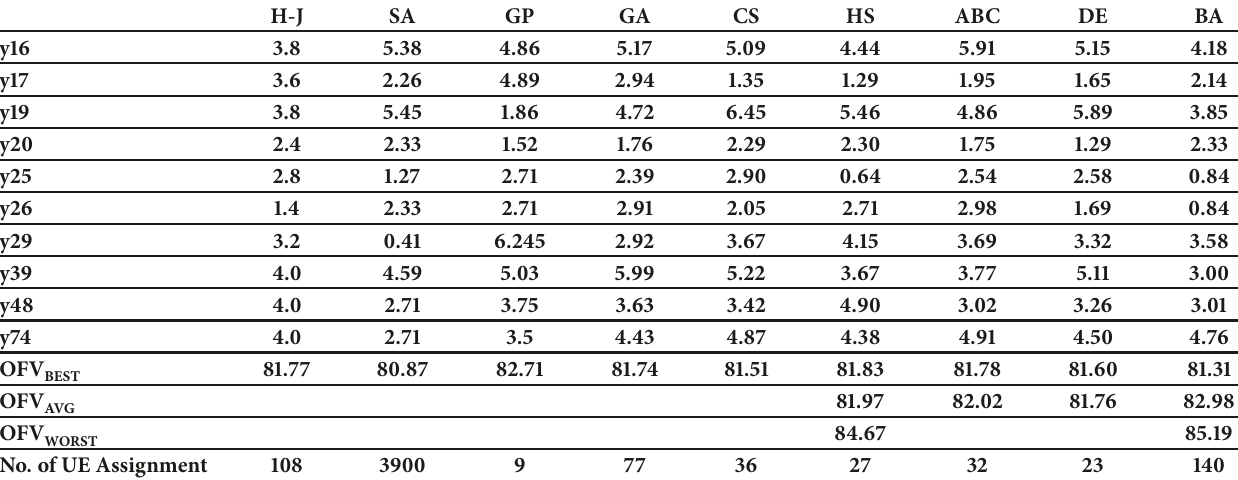
Figure 6: A 12-node test network with 4 intersections showing the signal value of 5 different phases. Table 7: Comparative analysis of TNDP for Sioux Falls